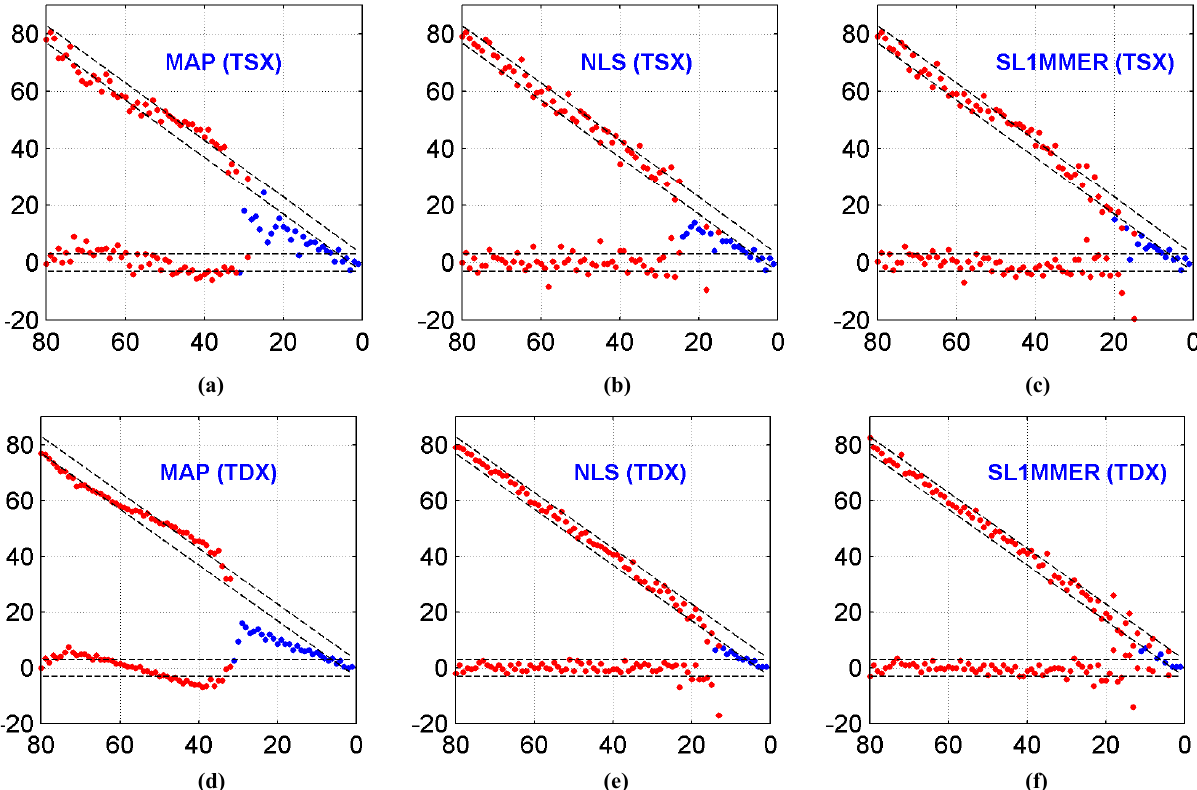
Figure 7. Estimated elevations [m] of two scatterers of equal reflectivity of increasing elevation distance. Shown are the results of MAP, (a), (d), NLS estimation (b), (e), and SL1MMER (c), (f). Upper plots: TSX case; lower plots: TDX case. The true positions are a horizontal line referring to the ground and a diagonal line referring to the scatterer at variable elevation. (Blue: detected single scatterer; red: detected two